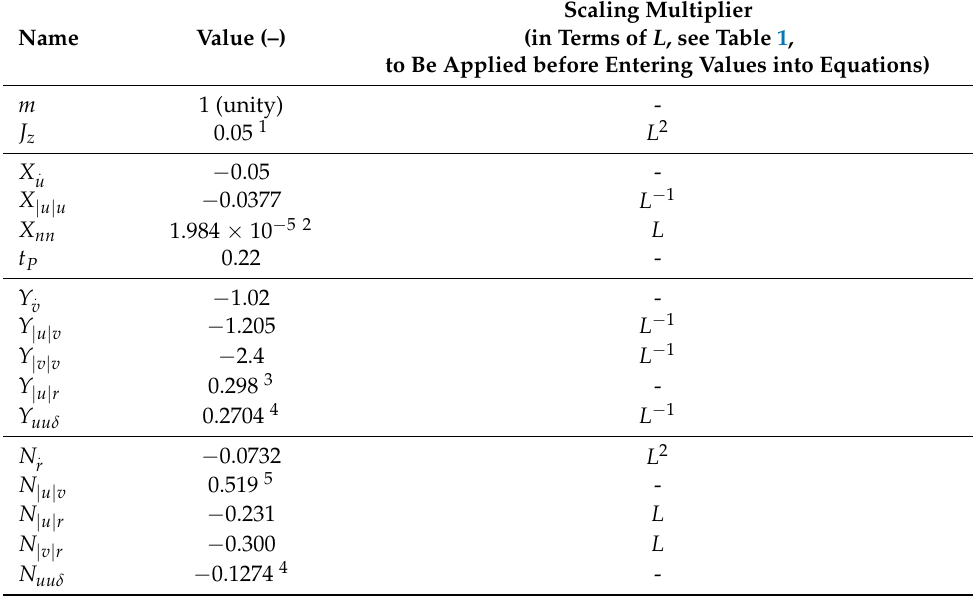
Table 2. Model parameters and hydrodynamic derivatives (full scale, deep water